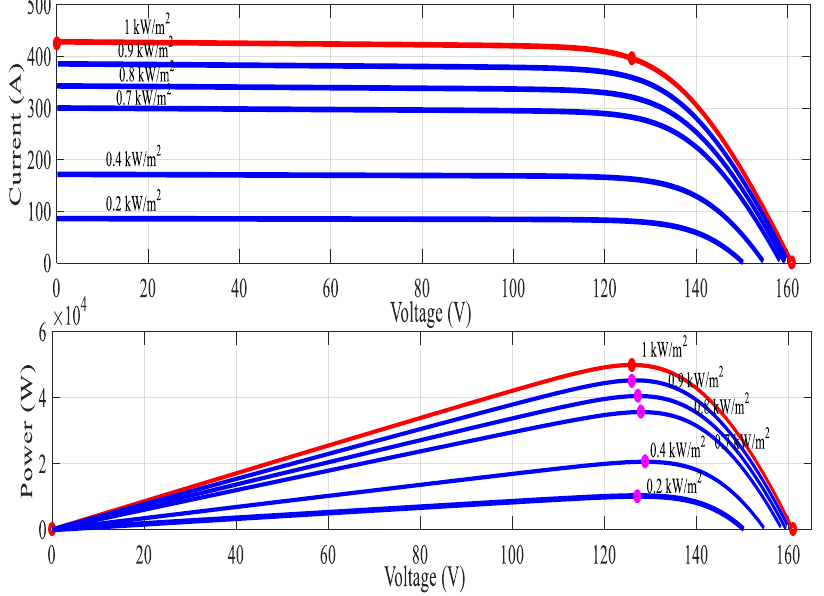
Figure 8. I-V and P-V characteristics of the PV array under study.